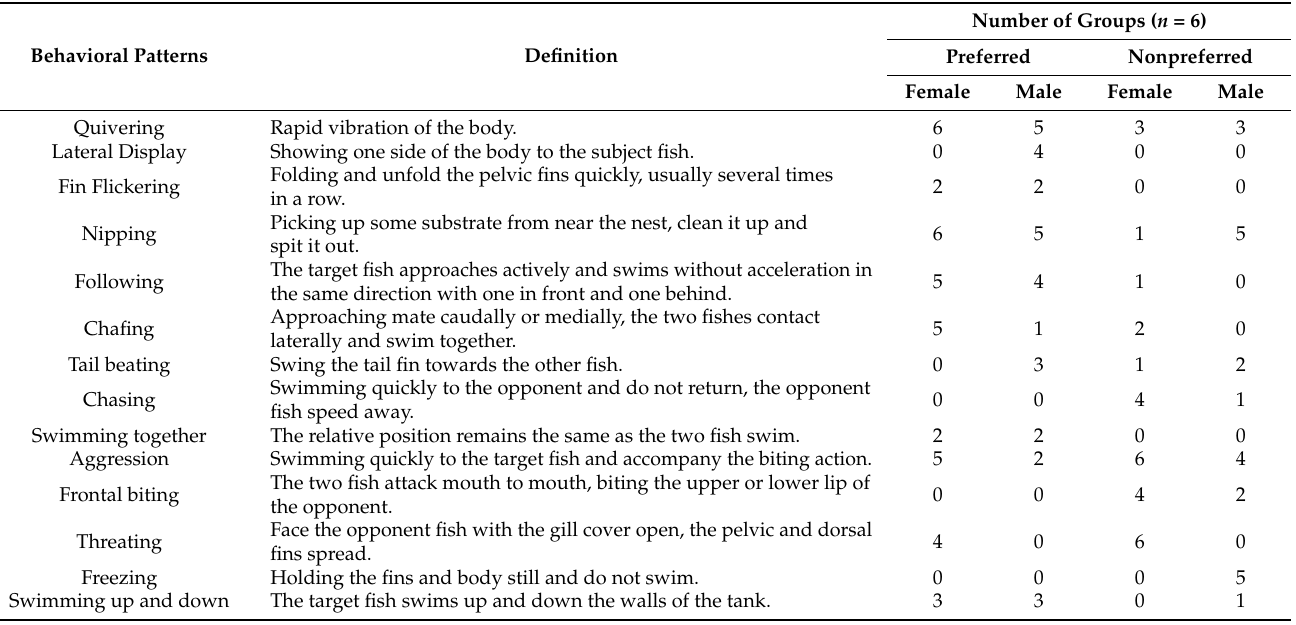
Table 4. Behavioral patterns of females and their preferred and non-preferred